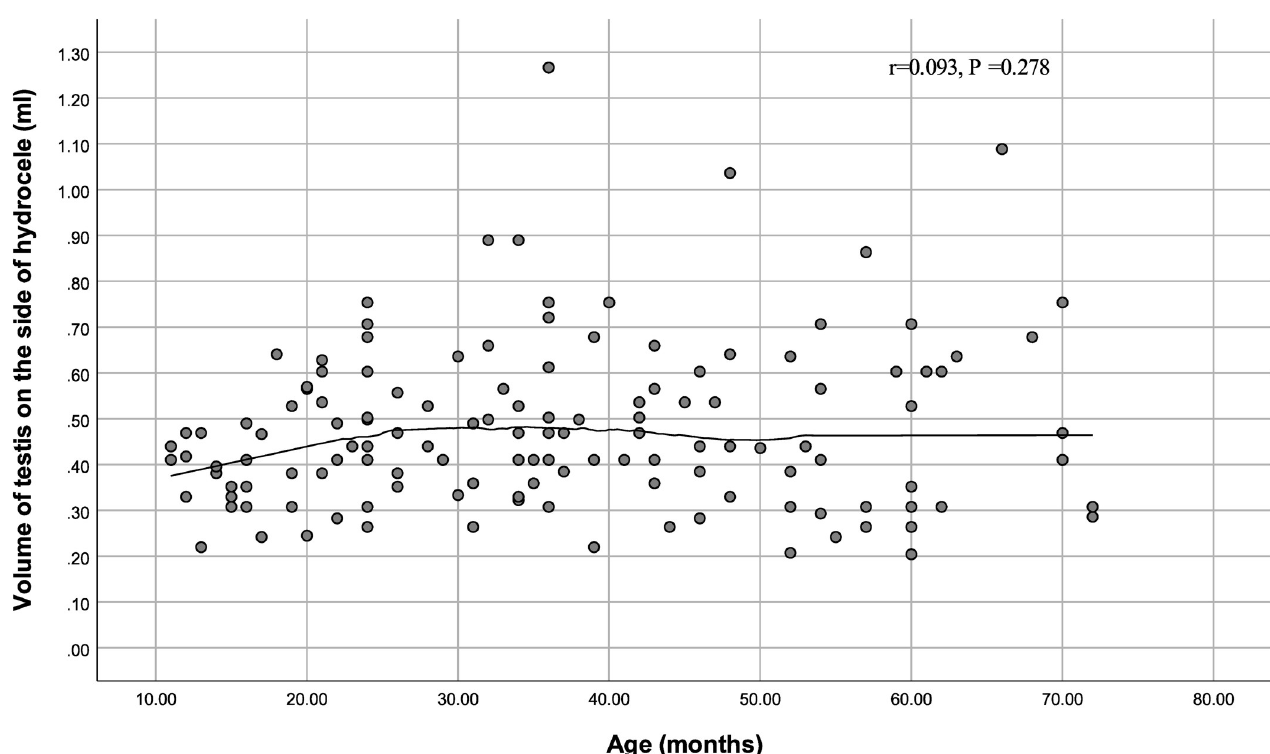
Fig 1. Scatter plot of age and volume of testis on the hydrocele